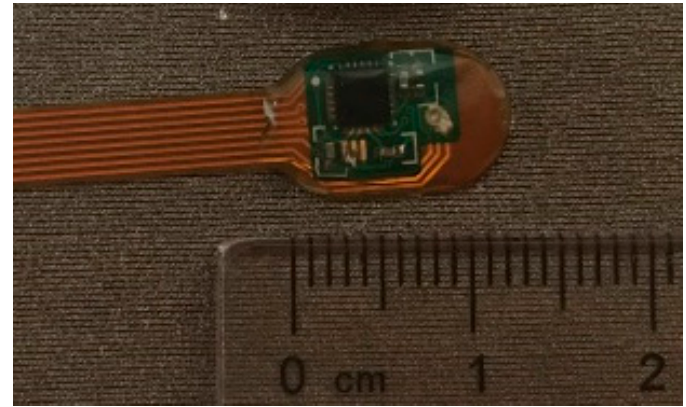
Figure 14. The integration of the circuit board and the conductive fabric.